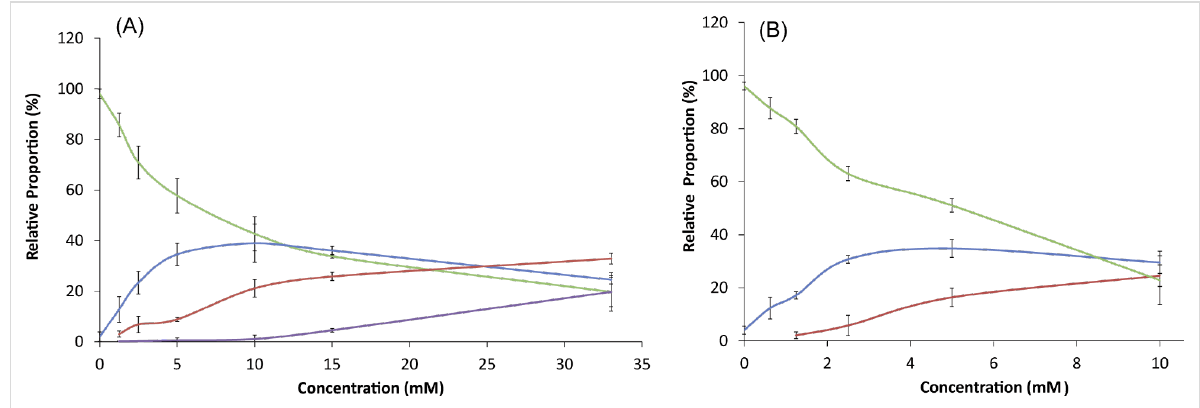
Figure 3: Relative incorporation of the D 3 -label into erythromycin (A) and rapamycin (B), depending on the fed concentration of rac - 4 . Color coding: green: no incorporation; blue: single; red: double; magenta: triple incorporation as detected by LC/ESI–MS.